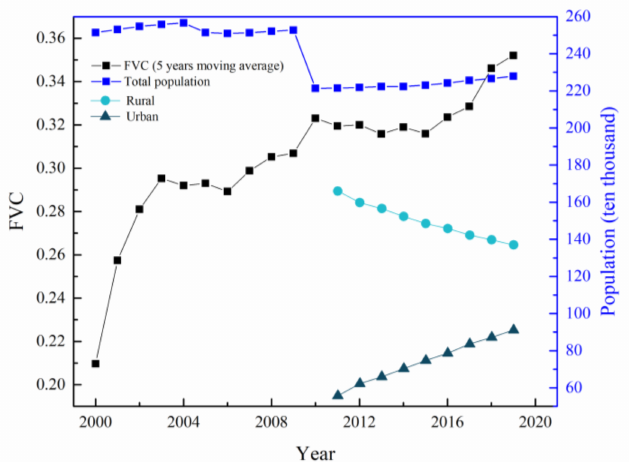
Figure 15. Relationship between population and FVC variation from 2000 to 2019 in Qingyang city.